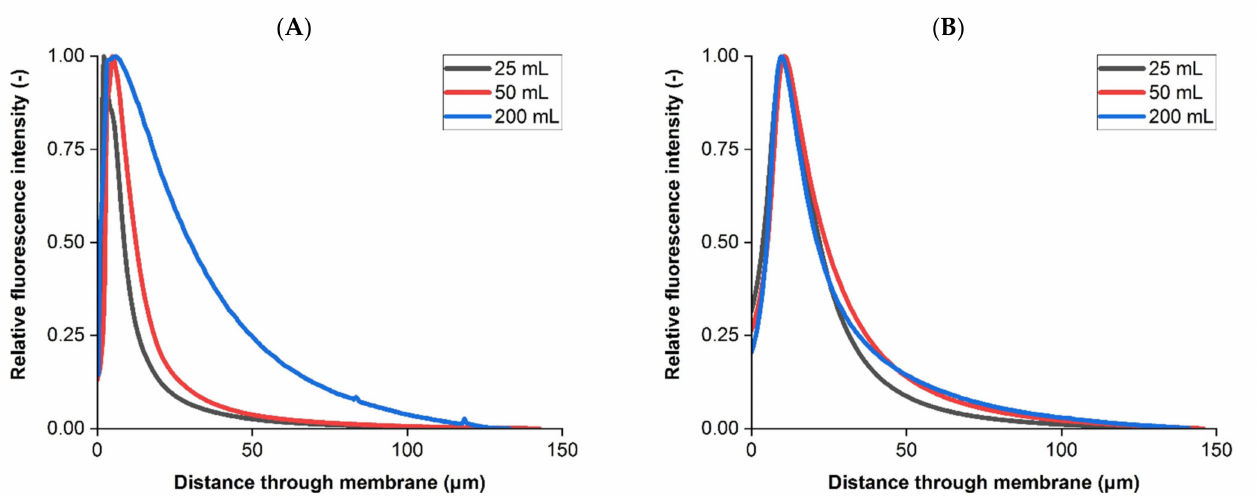
Figure 8. Fluorescently labelled bacterial challenges at increasing load volumes from 25 mL to 200 mL. ( A ) Upstream membrane. ( B ) Downstream membrane. Intensity profiles presented are based on averaged measurements from all 2D slices from a single sample imaged using CLSM. Filtration was performed at a constant differential pressure of 0.14